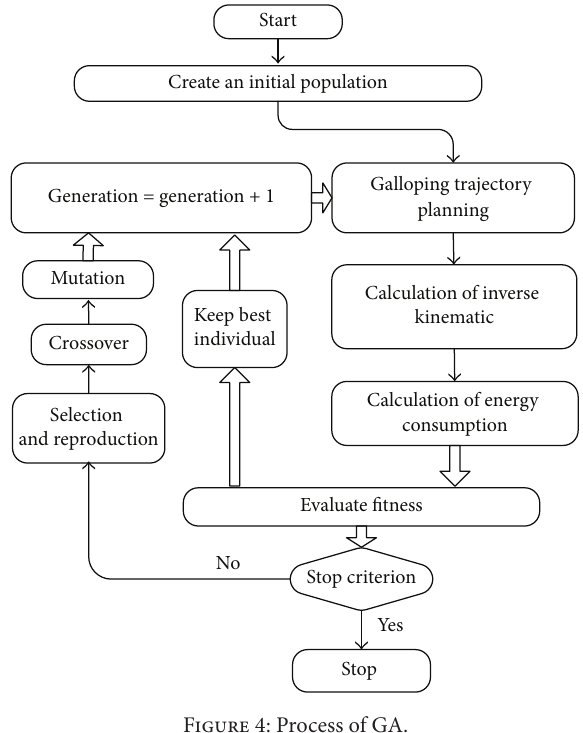
Figure 4: Process of GA.